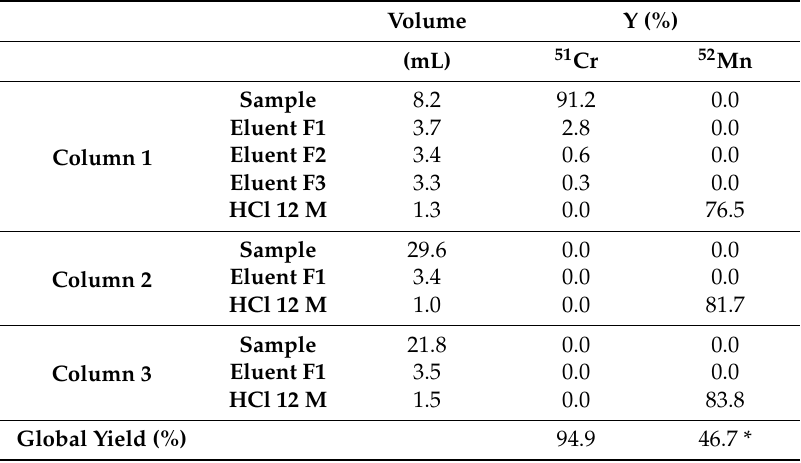
Table 10. Extraction yield in semi-automation separation of Mn/Cr.